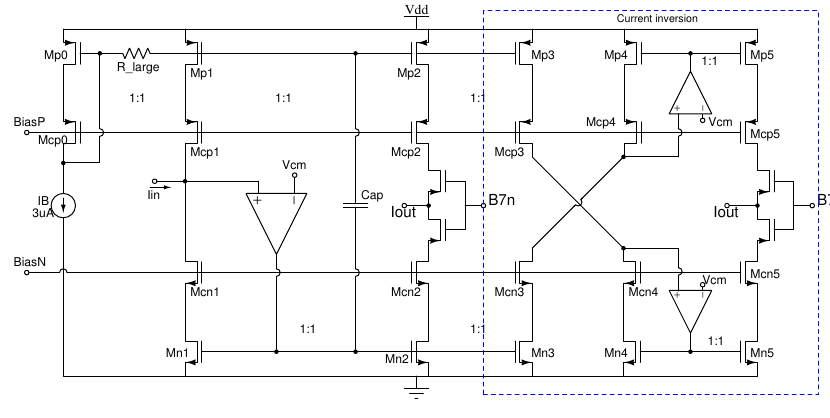
Figure 3. Sign circuit